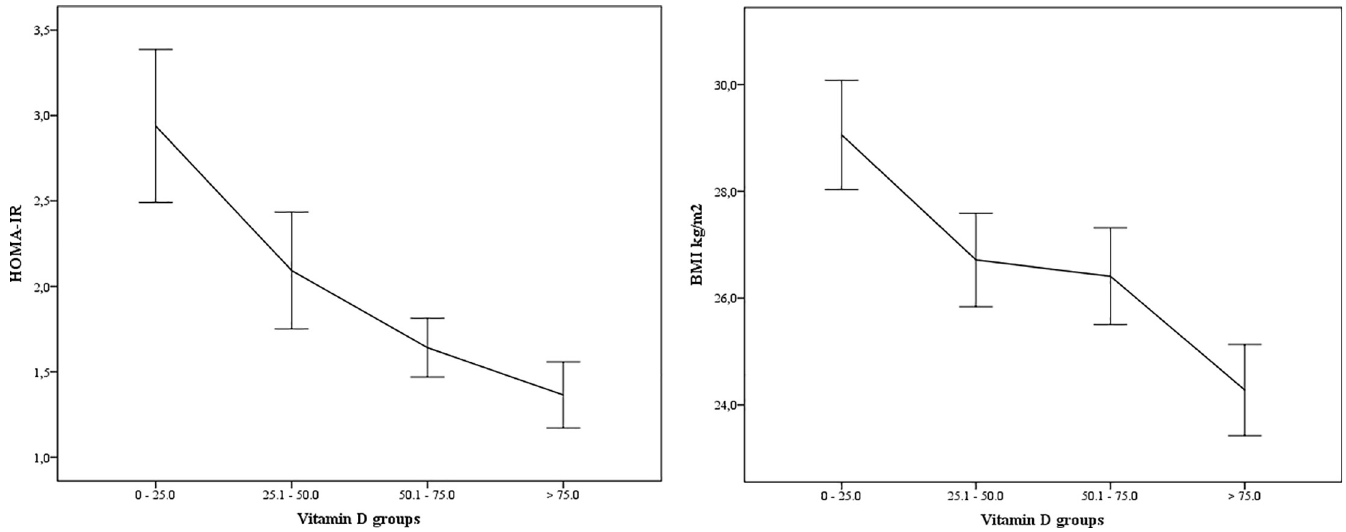
Fig 1. Association between serum 25(OH)D (nmol/l) groups and HOMA-IR and BMI.